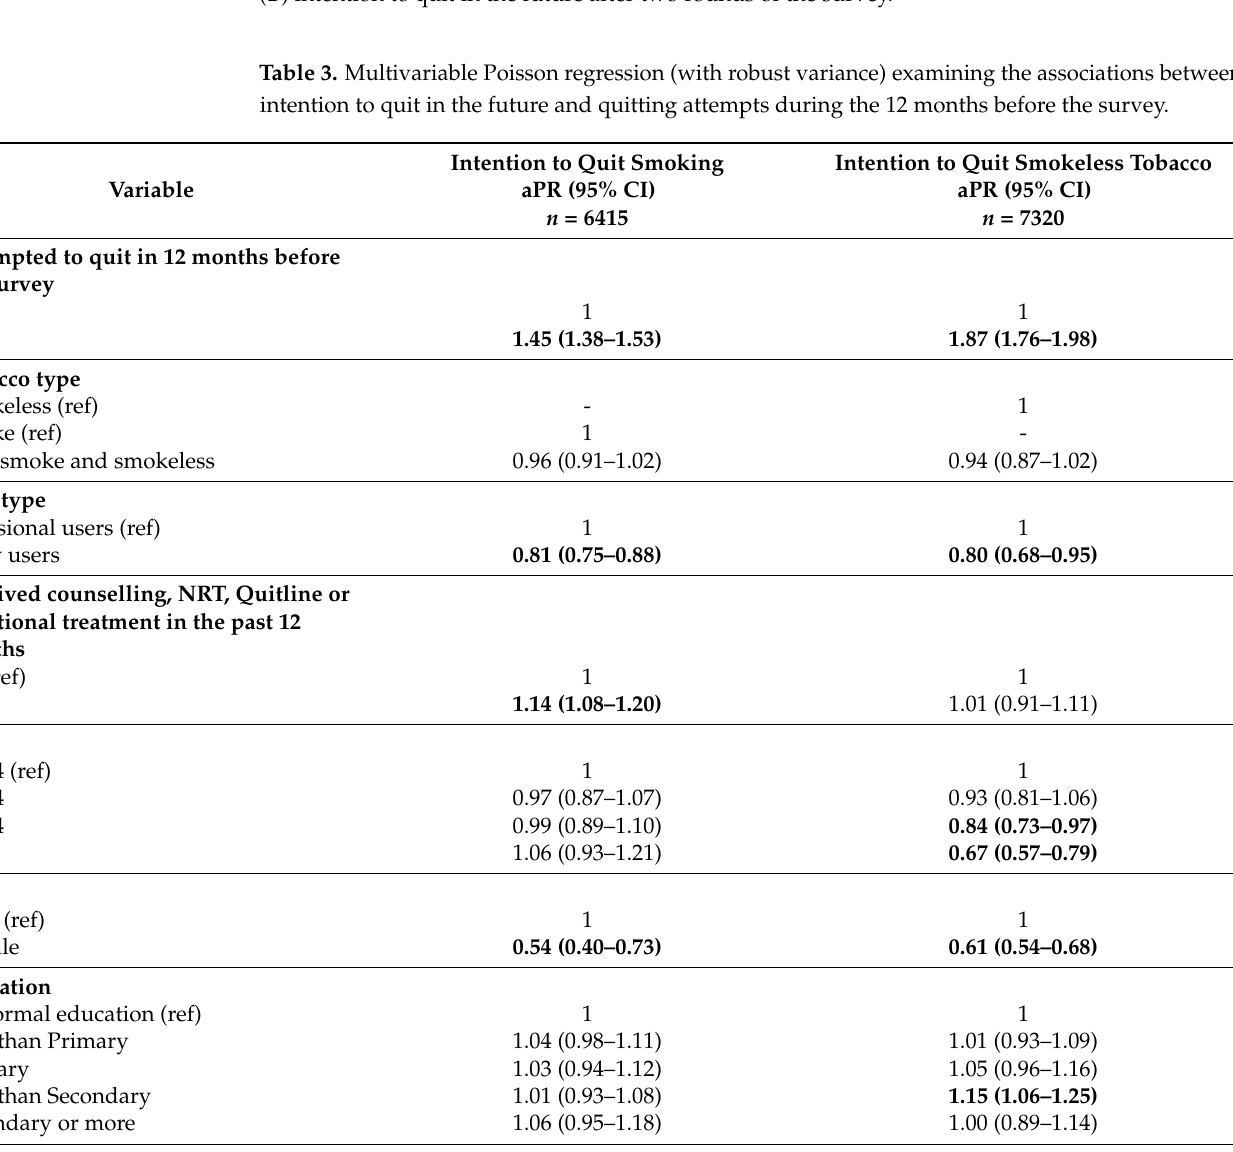
Figure 2. Predictive probabilities of ( A ) quitting attempt in the 12 months prior to the survey and ( B ) intention to quit in the future after two rounds of the survey.